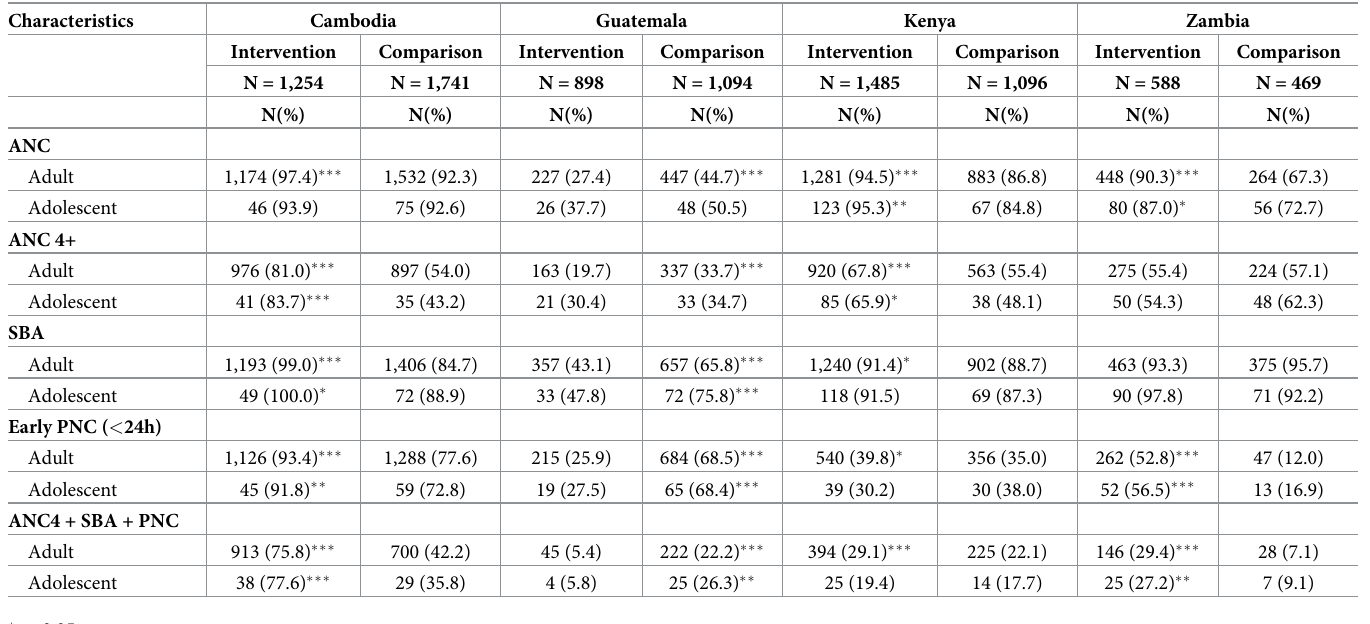
Table 4. Care-seeking characteristics of adolescents and adult women in intervention vs comparison study sites—Post intervention.